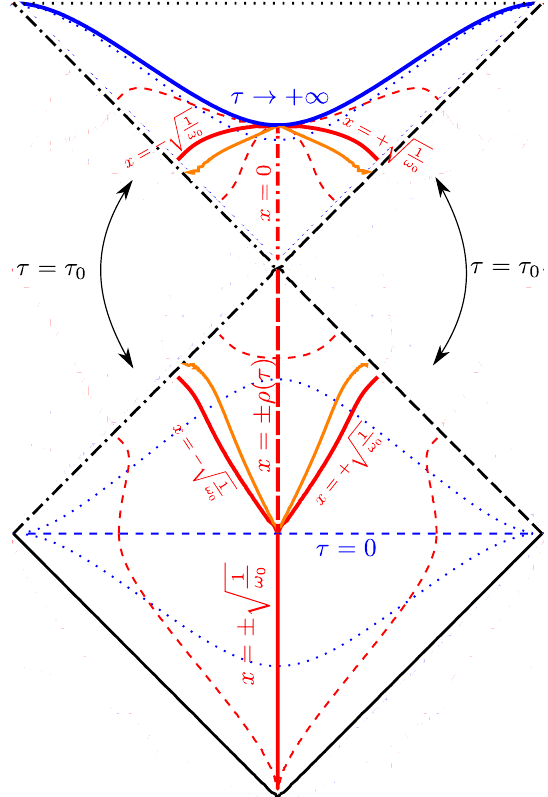
p Figure 14. Penrose diagram for emergent space-time when ! 0 = 2 ! 1 = 1. The black dot-dashed lines and dashed lines represent (cid:28) = (cid:28) 0 where (cid:28) 0 is de(cid:12)ned in (4.4) and should be glued respectively. Blue dotted lines are constant (cid:28) lines; specially, (cid:28) = 0 when the abrupt quench occurs are plotted in the blue dashed line; (cid:28) ! 1 i.e. in(cid:12)nite future is plotted in blue solid line. Red dashed lines are q 1 constant x lines. The special value of x , x = (cid:6) , is plotted in thick red solid lines; it splits into ! 0 two lines at (cid:28) = 0. x = (cid:6) (cid:26) ( (cid:28) ), is plotted in thick red dashed line. These separate two disconnected space-times corresponding to the (cid:13)uctuations of the left and right fermi surfaces. These two pieces connect at (cid:28) = (cid:28) 0 . x = 0 is plotted in the thick red dot-dashed line | this, however does not separate disconnected pieces. The orange solid lines demarcate the regions in which constant x lines are spacelike from those where they are